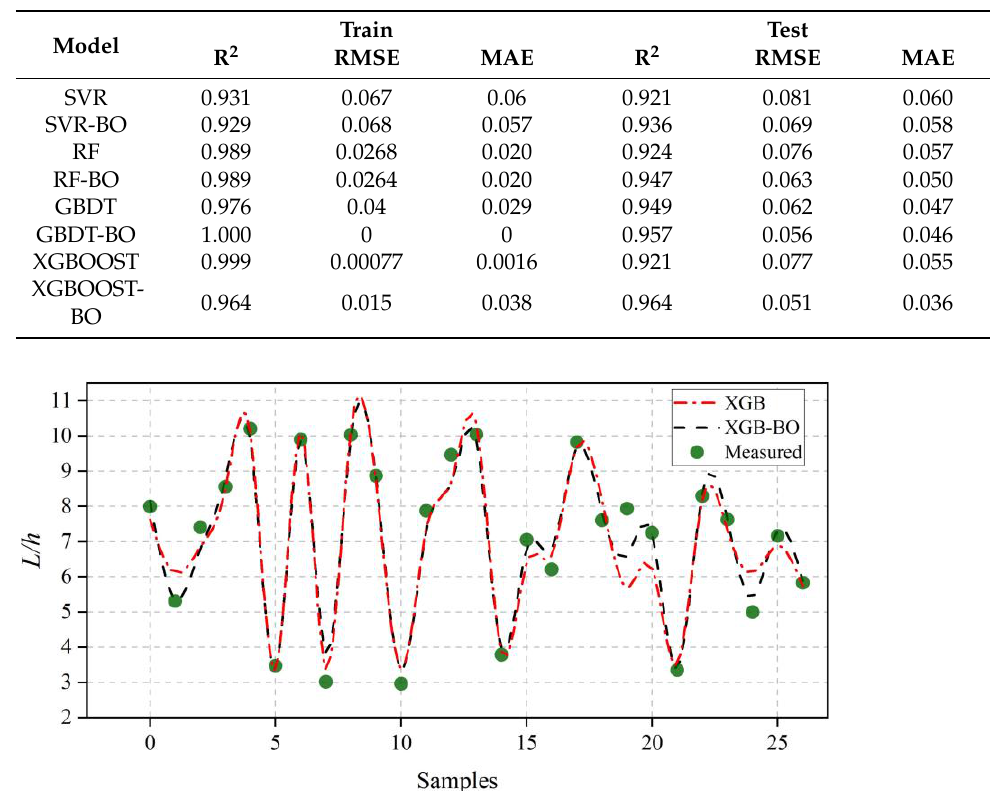
Figure 4. The ML models that implement BO optimization always present smaller